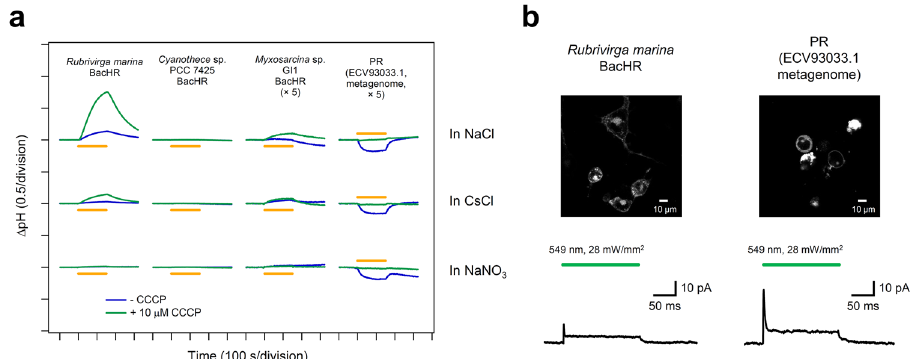
Fig. 6 Light-driven ion-transport activities of microbial rhodopsins showed longer λ max . a The light-induced pH change in the external solvent of E. coli cells expressing four microbial rhodopsins that showed a λ max ≥ 20nm longer than the base wavelength of the subfamily. The data obtained without and with 10 μ M CCCP are indicated by the blue and green lines, respectively, in 100mM NaCl, CsCl, and NaNO 3 . Light was illuminated for 150s (yellow solid lines). b Rubrivirga marina BacHR or PR (ECV93033.1 metagenome) were expressed in the membrane of ND7/23 cells (top image) and generated positive photocurrent in response to a green light pulse (200ms, 549nm, 28mW/mm 2 ). The traces in the bottom are typical records at a holding potential of 0